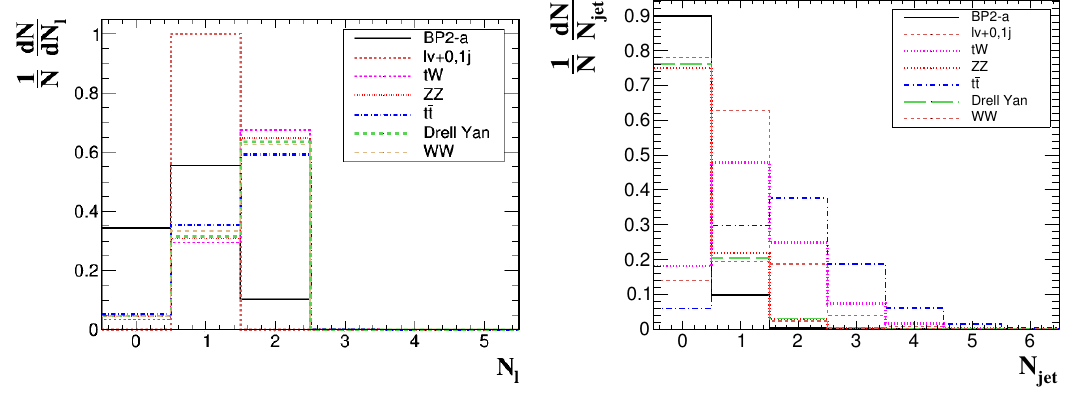
Figure 10 . Normalized distributions for lepton and jet multiplicity for benchmark BP2 and dominant SM backgrounds channels. respectively.